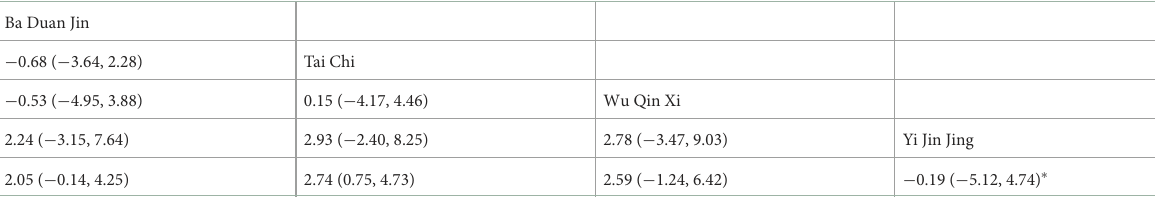
TABLE 2 Results of the network meta-analysis (SMD vs. 95% CI) of the effects of different traditional exercises on ECLSB in the elderly.